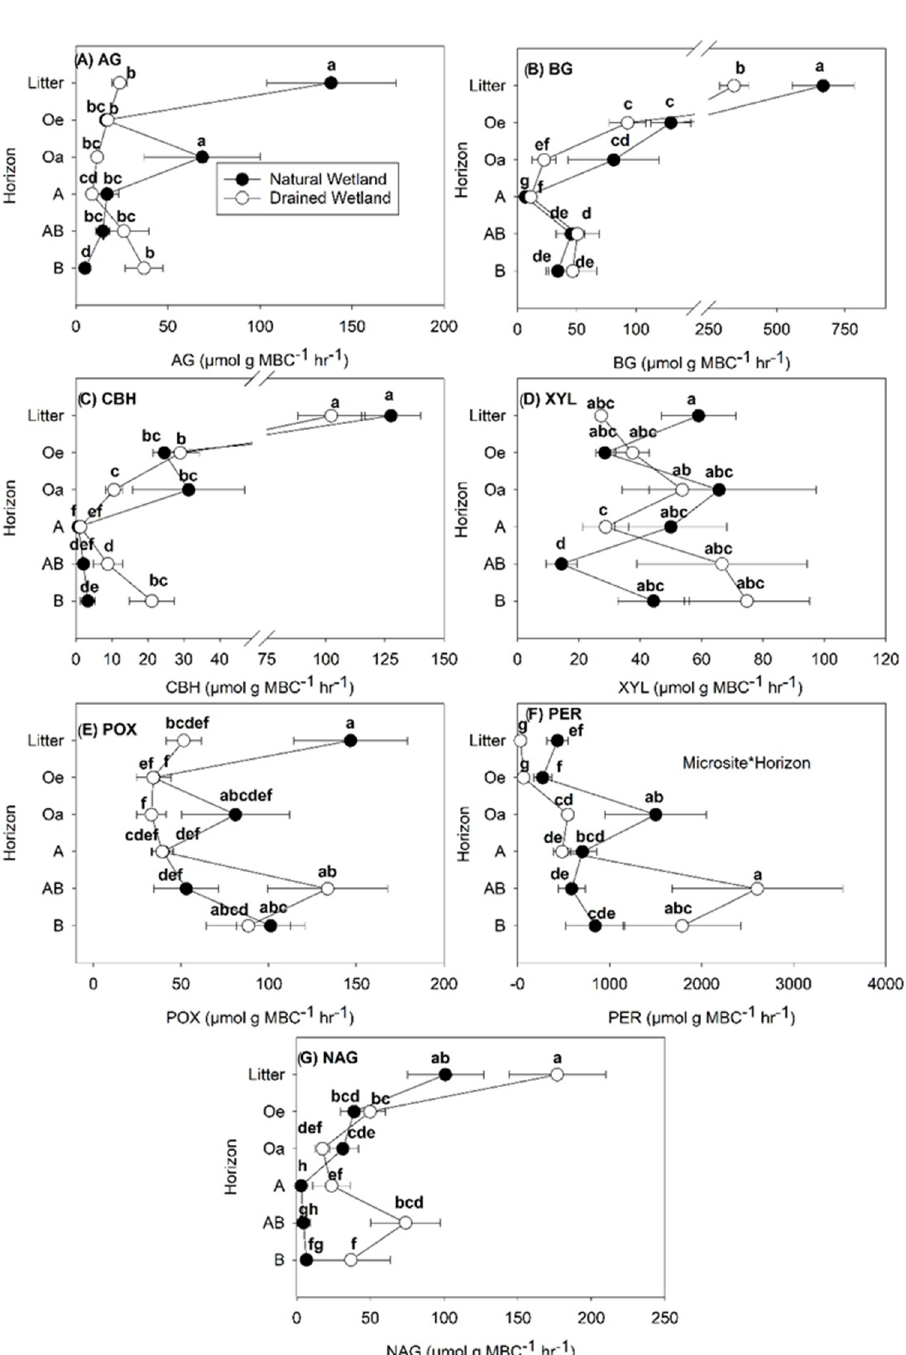
Figure 3. Specific enzyme activity rates calculated per unit mass of microbial biomass carbon (MBC) ( μ mol g MBC − 1 hr − 1 ) in soils collected from different soil horizons within a natural and managed freshwater forested wetland. Activity of seven enzymes were measured: ( A ) α -glucosidase (AG), ( B ) β -glucosidase (BG), ( C ) cellobiohydrolase (CBH), ( D ) xylosidase (XYL), ( E ) phenol oxidase (POX), ( F ) peroxidase (PER) and ( G ) N-acetyl glucosamide (NAG). Values are means with standard error ( n = 5) and averaged across microsite, depicting the site by horizon interaction found for most enzymes assayed. Lowercase letters represent significant differences ( p < 0.05) between each site and horizon when a significant site by soil horizon interaction was found. Uppercase letters represent significant differences between soil horizons when a soil horizon main effect only was found.